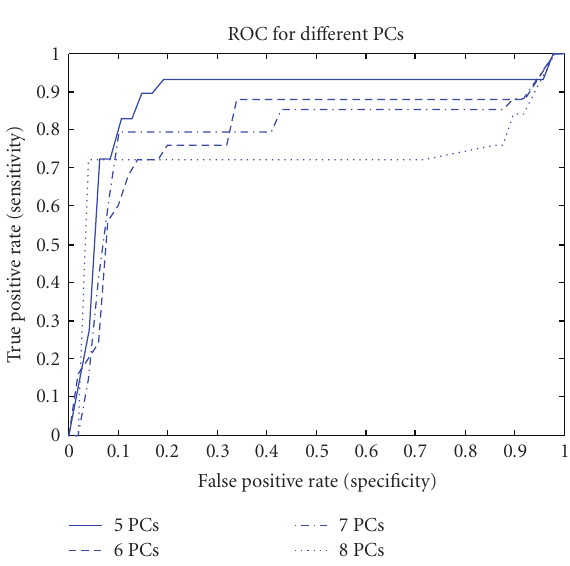
Figure 3: ROC plot for di ff erent values of selected principal components for testing set number 4.